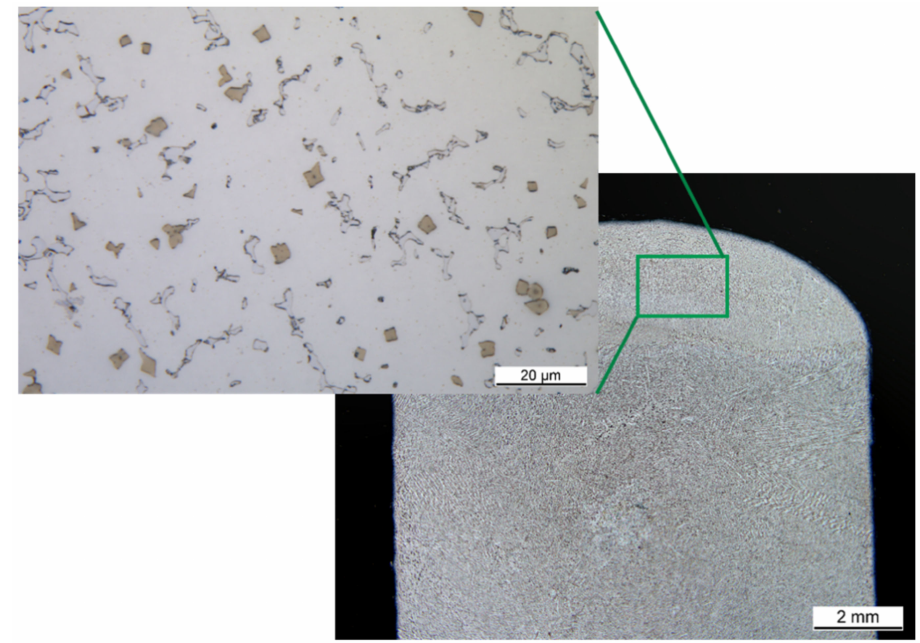
Figure 6. Microstructure of the re-melted sample.